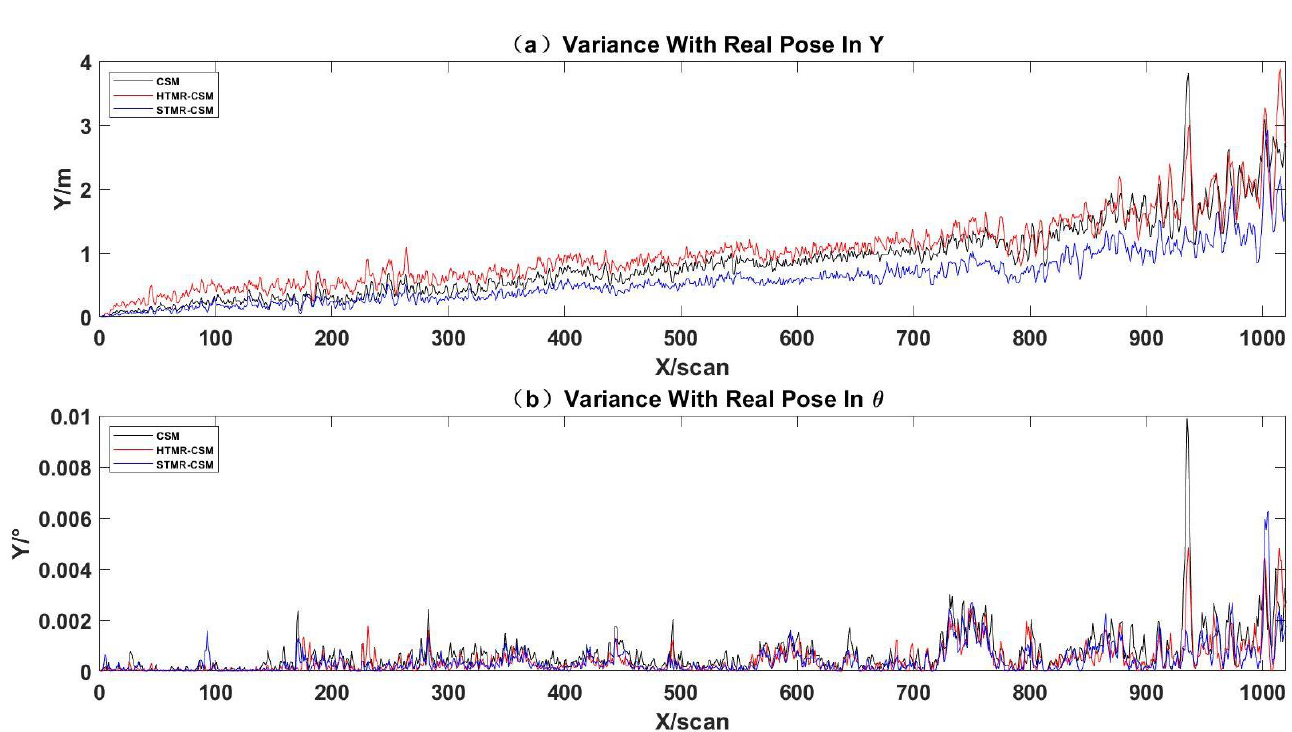
Figure 13. ( a ) The variance between the estimated pose of each scan and the real pose in Y. ( b ) The variance between the estimated pose of each scan and the real pose in θ.